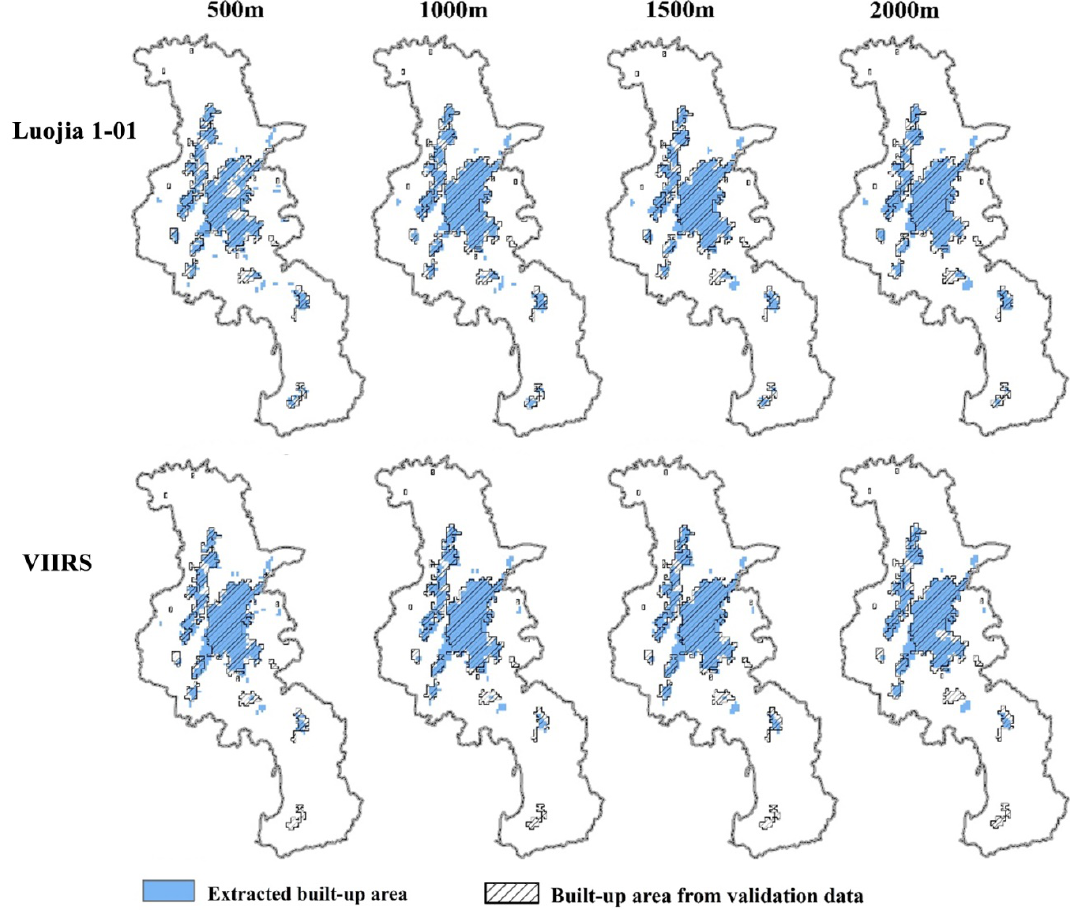
Figure 7. Comparison of extraction results and the validation data for urban built-up areas, in which blue areas indicate extracted built-up areas and hatched areas indicate built-up areas from the validation data. KDE was conducted respectively on VANUI_LUOJIA and VANUI_VIIRS under the search radius of 500 m, 1000 m, 1500 m, and 2000 m.